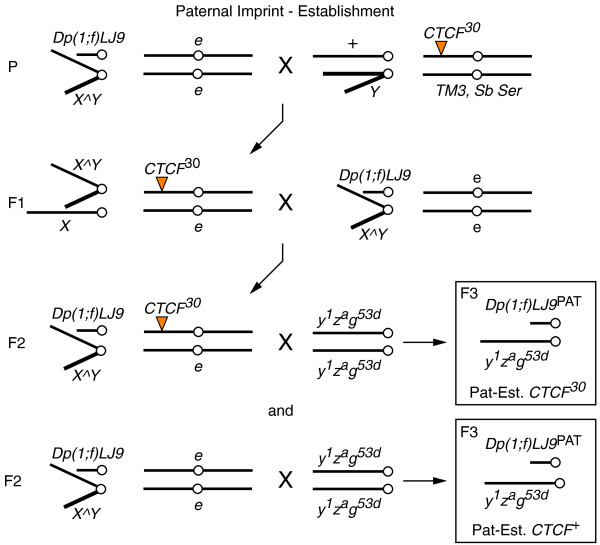
Mating schematic for testing dCTCF for an effect on the paternal establishment of the Dp(1;f)LJ9 imprint. Two primary sets of progeny and an external control were generated from this cross: progeny with a paternally-transmitted Dp(1;f)LJ9 mini-X chromosome from fathers with the CTCF30 mutation (Pat-Est. CTCF30) and progeny that also have a paternally imprinted Dp(1;f)LJ9 mini-X chromosome but from fathers wild type for CTCF (Pat-Est. CTCF+). External control crosses were produced by crossing F1 generation X^Y/Dp(1;f)LJ9; e/e males to y1zag53d/y1zag53d females (not depicted).